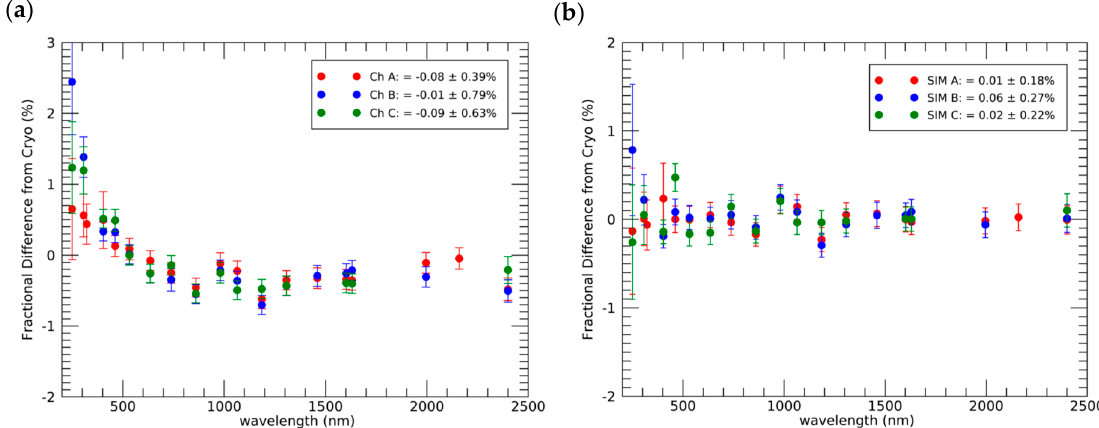
Figure 16. ( a ) Full SIM spectral irradiance measurement equation validation results compared against the cryogenic radiometer in irradiance. Shown here are all SIM channels with linear fit offsets and standard deviations. Common systematic effect is present in the results and indicates a common uncertainty in the unit level characterizations. The functional removal of this common bias is applied in ( b ), where spectral data have been directly calibrated against the CR measured irradiance.